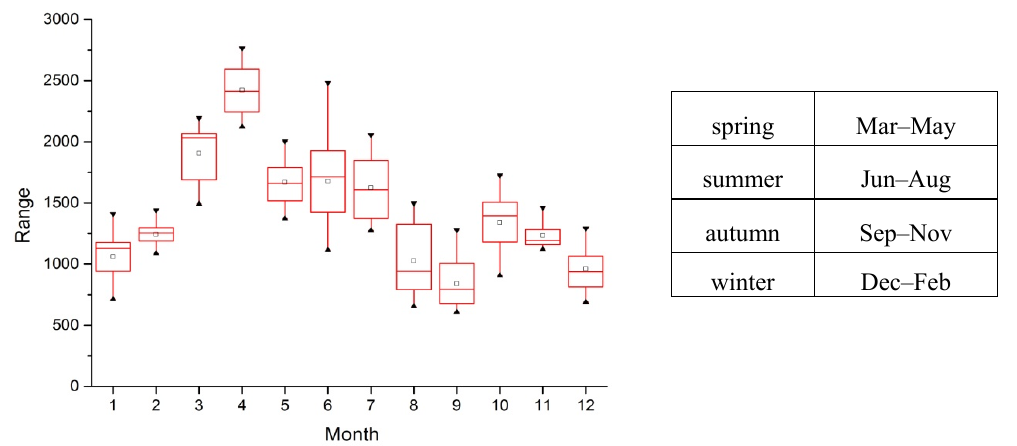
Figure 3. Monthly statistics of the atmospheric boundary layer height (ABLH). The boxes represent the mean of the maximum and minimum for each month, the triangles represent the monthly maximum and minimum, and the short horizontal lines represent the monthly